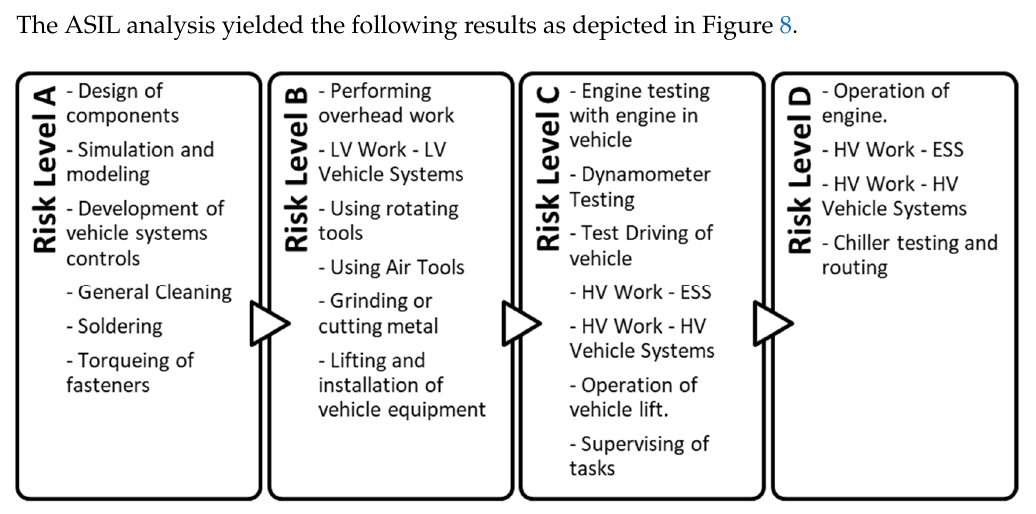
Figure 8. ASIL Ratings for the UWAFT Tasks.